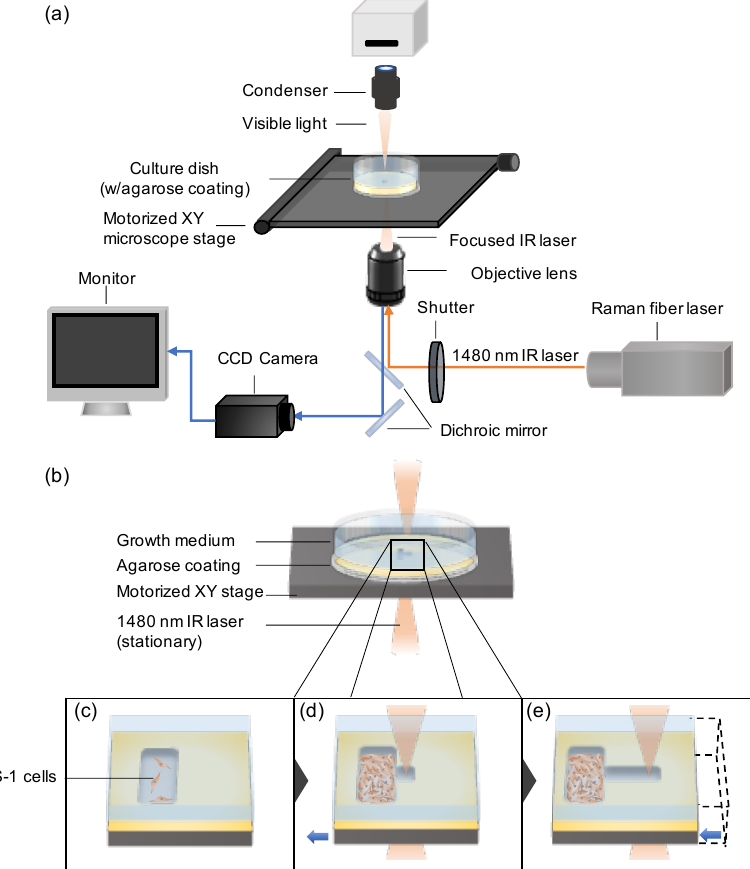
Figure 1. Photothermal agarose microfabrication technology for assessing collective cell dynamics. ( a ) Schematic of the agarose photo-thermal microfabrication device system. A 1480 nm wavelength infrared (IR) laser beam is focused by the objective lens onto the culture dish (w/agarose coating and water) and absorbed by the water present. The induced heat melts a portion of agarose coating locally, generating agarose removed areas where the cells can adhere. Controlling the motorized XY microscope stage manually or via program enables the fabrication of patterns accordingly to the user’s interest. ( b ) Magnified schematic of the agarose coated cultivation dish with laser irradiation for fabrication. ( c – e ) Method of photothermal microfabrication of straight microchannels on one-side of agarose. First, mouse-derived endothelium-like cell line, MILE SVEN 1 (MS-1) cells were seeded and adhered on the reservoir chamber ( c ). When the cells proliferated and became confluent in the reservoir, micorchannels were formed with focused IR laser ( d ). The shapes of microchannels were fabricated through the movement of XY microscope stage ( e